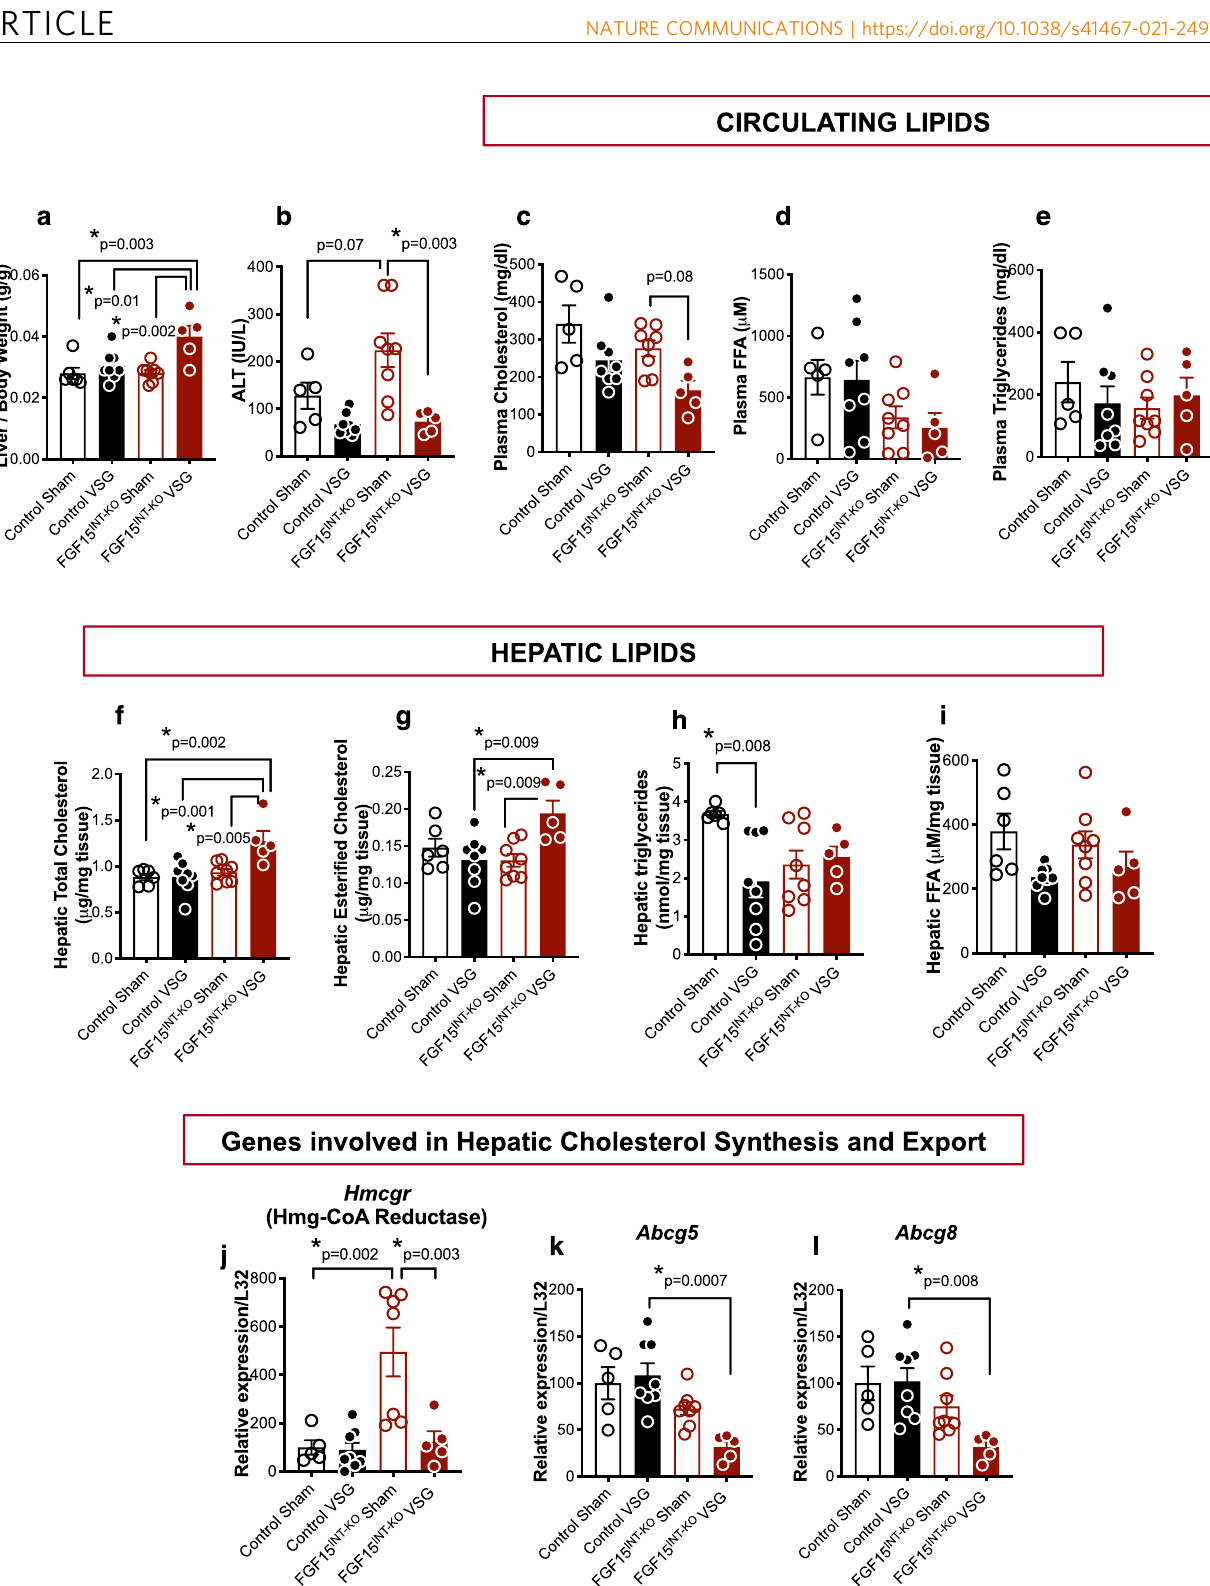
Fig. 5 Loss of intestinal FGF15 results in aberrant hepatic lipid metabolism following VSG. a Liver weight normalized to body weight. b Alanine aminotransferase (ALT) plasma levels. c Plasma cholesterol. d Plasma-free fatty acids (FFA) and e Plasma triglycerides (postprandial, 12 weeks post- surgery). f Total hepatic cholesterol. g Hepatic esteri fi ed cholesterol. h Hepatic triglycerides. i Hepatic free fatty acids. Hepatic RNA expression of cholesterol synthesis gene j . Hmcgr and cholesterol export genes k . Abcg5 and l . Abcg8 . Animal number for ( a – i ) and ( k , l ): Control Sham ( n = 5), Control VSG ( n = 8), FGF15 INT-KO Sham ( n = 8), FGF15 INT-KO VSG ( n = 5). Animal number for j: Control Sham ( n = 5), Control VSG ( n = 8), FGF15 INT-KO Sham ( n = 7), FGF15 INT-KO VSG ( n = 5). Data are shown as means ± SEM. * p < 0.05 (two-way ANOVA with Tukey ’ s post hoc